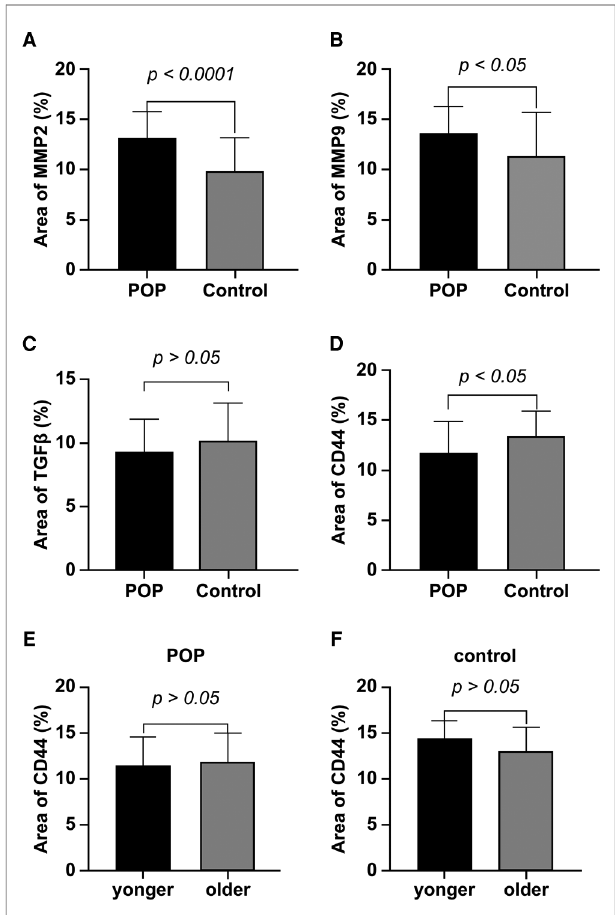
FIGURE 2 | Quanti fi cation of matrix metalloproteinase (MMP)-2 ( A ), MMP-9 ( B ), transforming growth factor (TGF)- β ( C ), and CD44 ( D ) expression in uterosacral ligaments. Sections of uterosacral ligaments were stained with antibodies against CD44, TGF- β , MMP-2, and MMP-9, and counterstained with Harris hematoxylin. The percentages of positively stained areas were quanti fi ed using ImageJ software and are expressed as means±standard deviations. POP, pelvic organ prolapse.